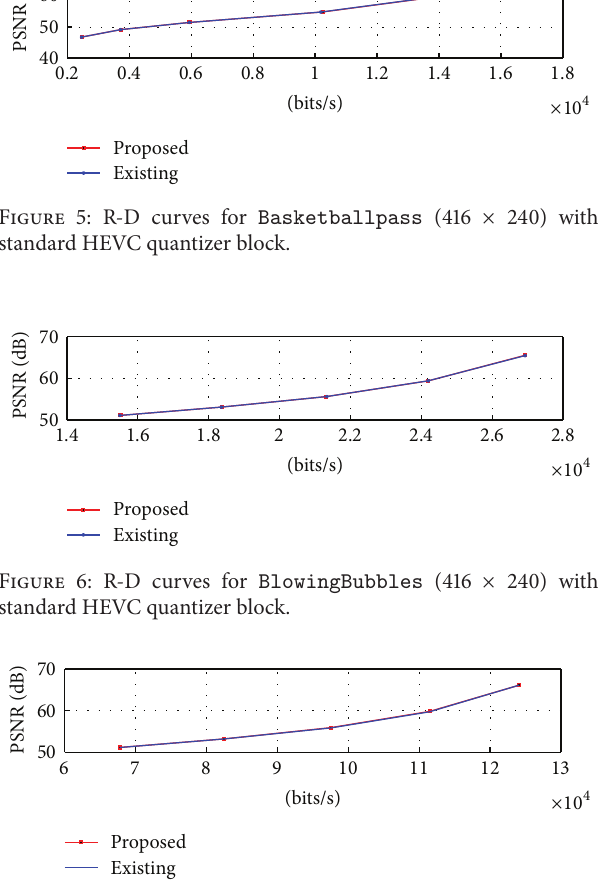
Figure 7: R-D curves for BQMall (832 × 480) with standard HEVC quantizer block.